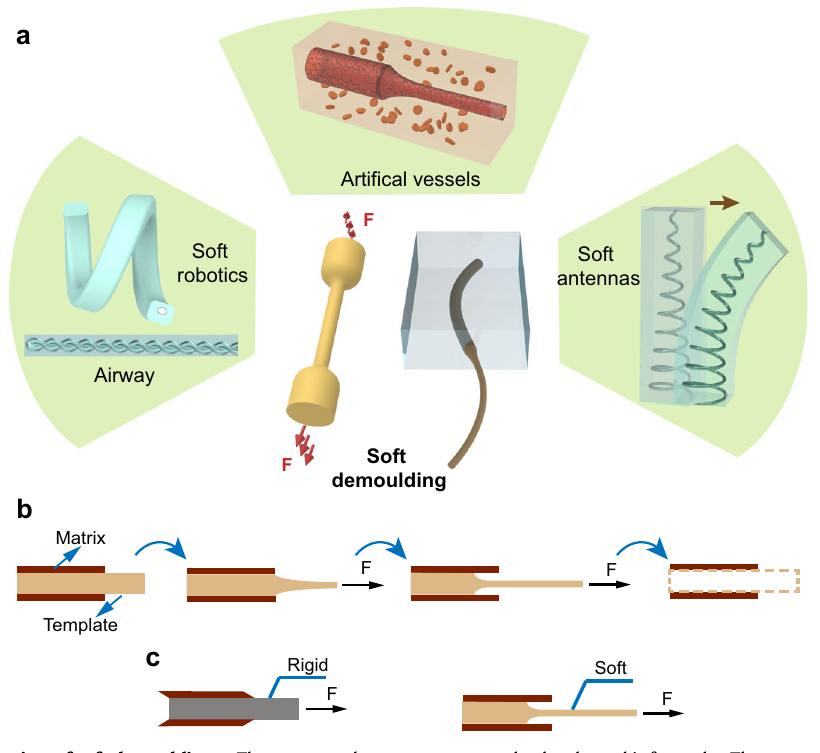
consequently, the channel is formed. c The comparison of extraction of a rigid template(conventionalmethod)andasofttemplate(proposedinthiswork),which are shear-dominated demoulding and peeling-dominated demoulding,